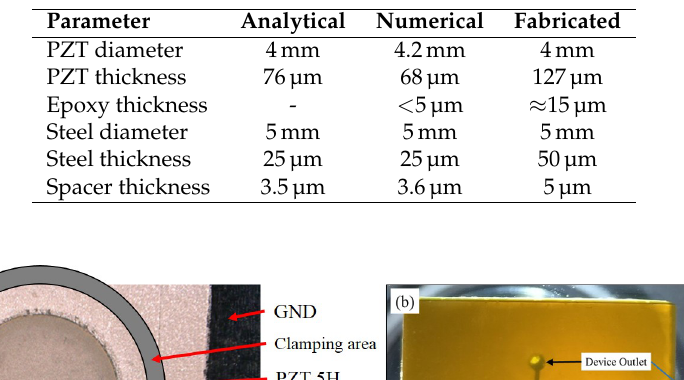
Table 1. Microvalve design parameters.